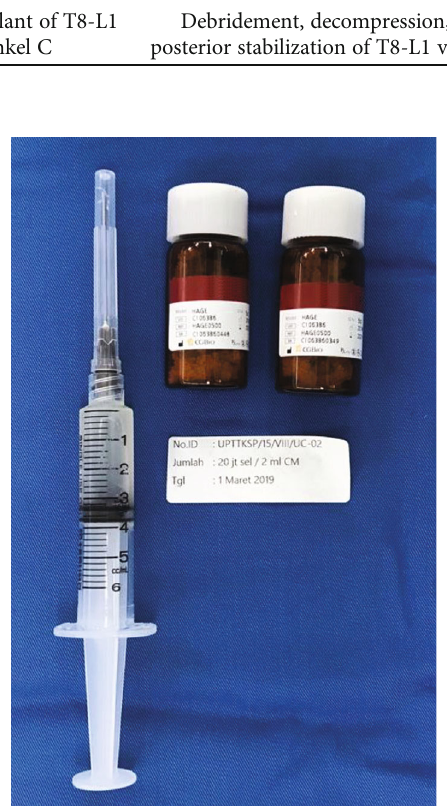
Figure 1: Twenty million umbilical cord mesenchymal stem cells (UC-MSCs) and hydroxyapatite-based sca ff olds used in the